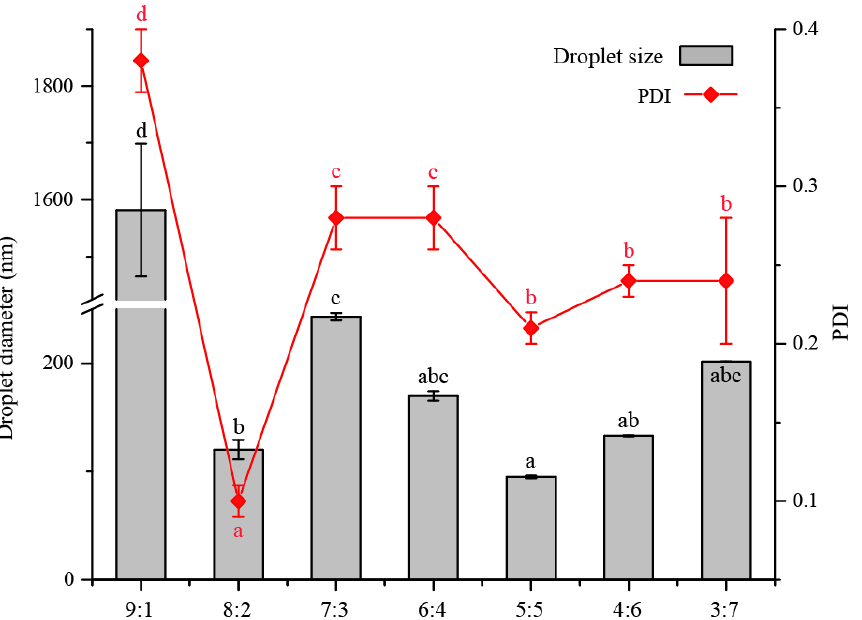
Figure 2. Influence of surfactant-to-oil (SOR) on the average droplet diameter of systems containing 2.5 wt% ZBEO. abcd , means within the same column followed by the same letter are not significantly different ( p > 0.05) in one-way analysis of variance and Duncan’s test.